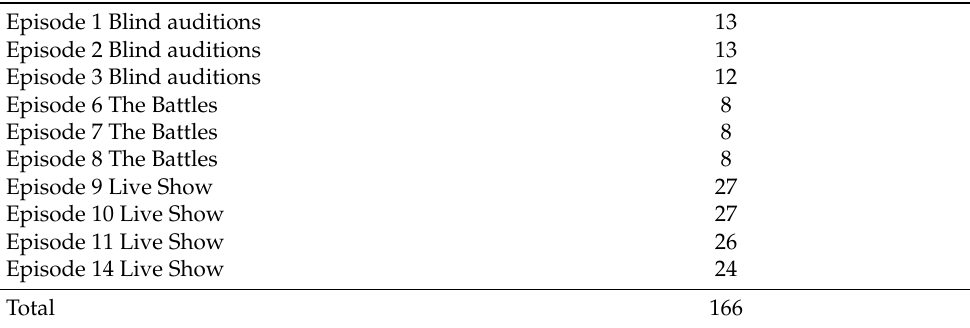
Table 1. The different kinds of shows and the numbers of communication instances.